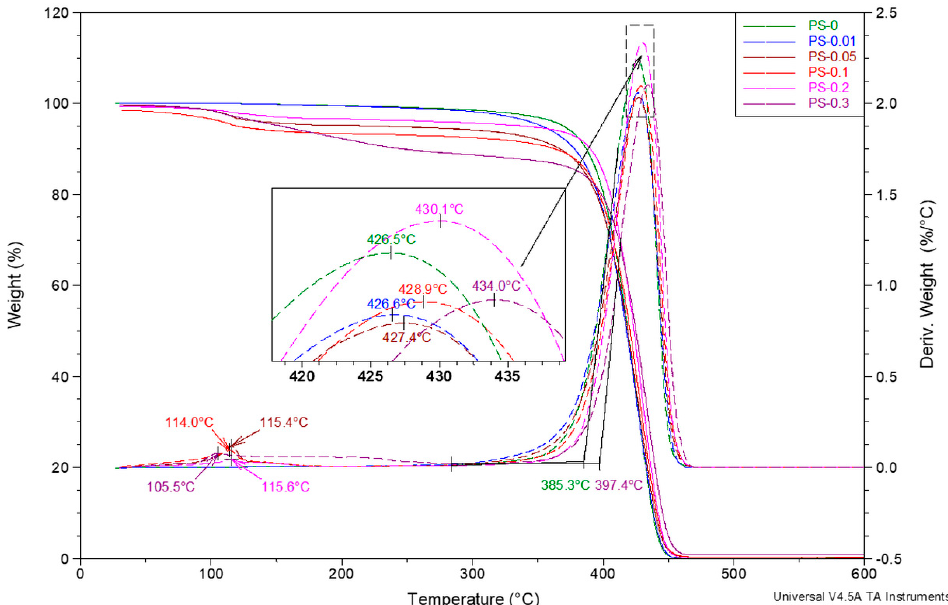
Figure 7. TGA and DTG curves of pure PS and nanocomposite beads with the different content of rGO.